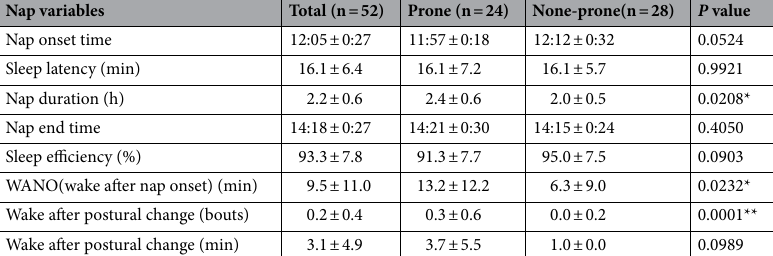
Table 3. Daytime nap variables by position (mean ± SD). * < 0.05, ** <